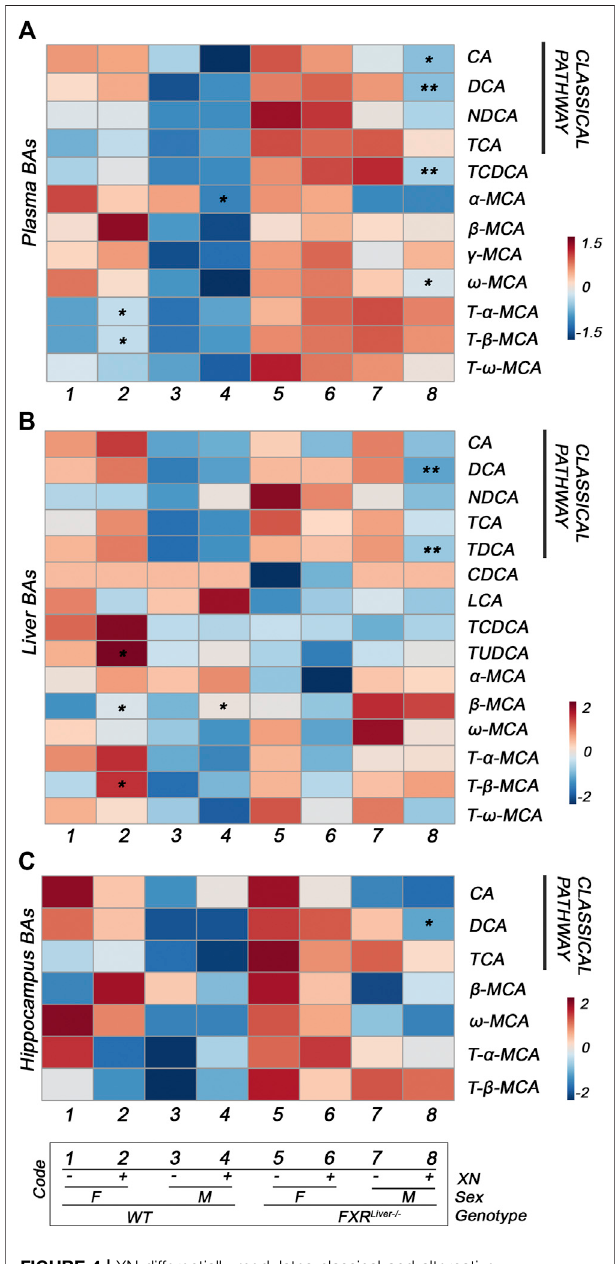
FIGURE 4 | XN differentially modulates classical and alternative pathways of synthesis in WT vs. FXR Liver − / − mice. Heatmaps of individual BA concentrations in the plasma (A) , liver (B) and hippocampus (C) of HFD-fed WT and FXR Liver − / − mice. * p < 0.05, ** p < 0.01, *** p < 0.001 for effect of XN treatment ( n (cid:2) 7 – 10 per group). Abbreviations: chenodeoxycholic acid (CDCA), cholic acid (CA), deoxycholic acid (DCA), lithocholic acid (LCA), muricholic acid (MCA), nordeoxycholic acid (NDCA), taurochenodeoxycholic acid (TCDCA), taurocholic acid (TCA), tauromuricholic acid (T-MCA), taurodeoxycholic acid (TDCA), tauroursodeoxycholic acid (TUDCA).